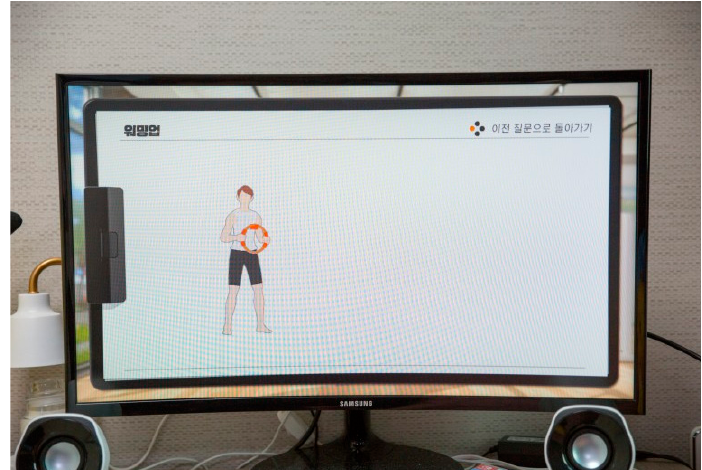
Figure 4. Nintendo switch game